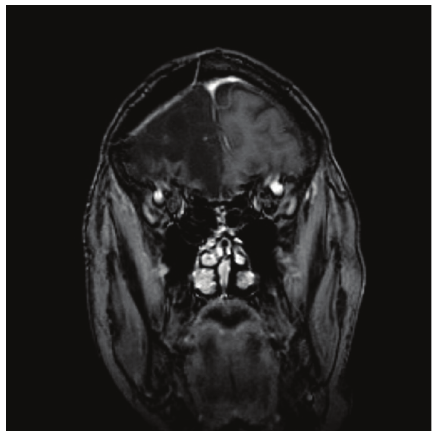
Figure 3: MRI of the brain showing no mass or enhancing